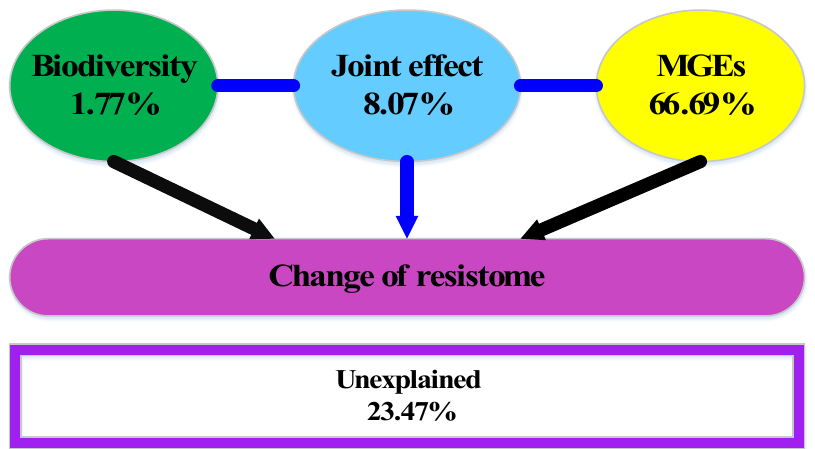
Figure 5. Variation partitioning analysis differentiates the effects of biodiversity and MGEs on resistome alterations in aquaculture environments.